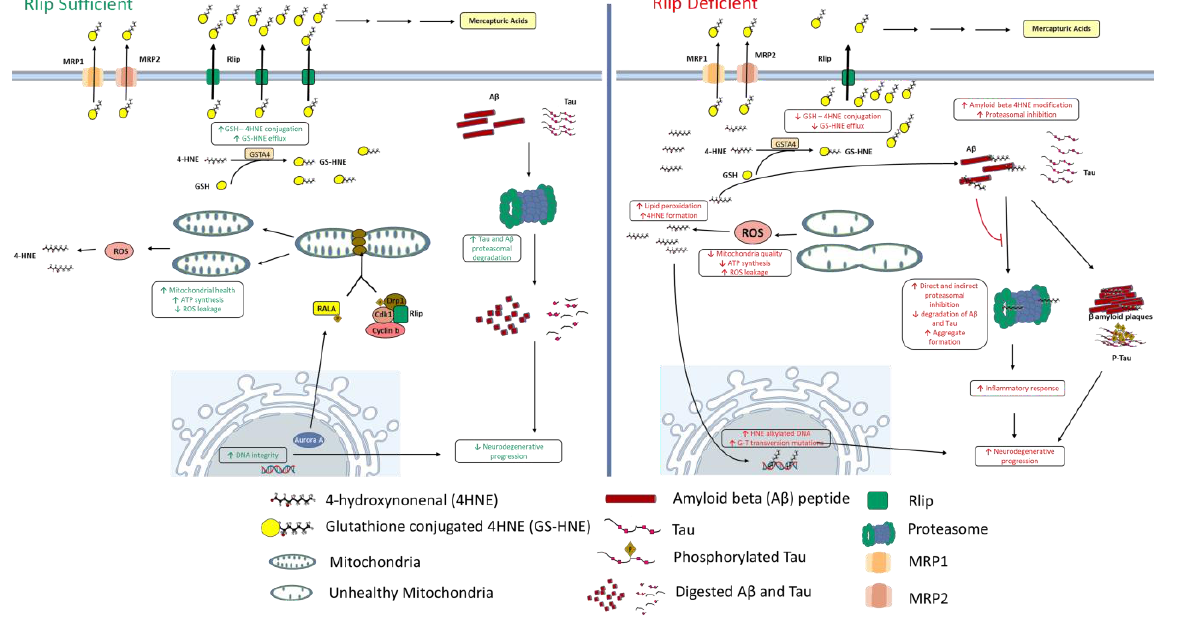
Figure 2. Model of Rlip in mitochondrial health, oxidative stress and DNA damage. The left panel depicts cellular conditions when Rlip is abundant. Under this scenario, mitochondria are healthy and producing minimal ROS, 4- HNE is cleared from the cell, Aβ and Tau are degraded, and the DNA is not subjected to insult. The right panel depicts cellular conditions of Rlip deficiency. Un- healthy mitochondria emit greater ROS, leading to increased 4-HNE production. This 4-HNE is in- efficiently cleared from the cell, causing accumulation. Accumulated 4-HNE can cause adducts on DNA, proteasomes, and Aβ. 4- HNE adducts on both proteasomes and on Aβ can inhibit pro- teasomal function, inhibiting Aβ and Tau degradation and causing inflammation [50 – 54]. Aβ and p-Tau aggregation, along with neuroinflammation, can exacerbate neurodegeneration and progres- sion to AD. Our recent findings show that heterozygous Rlip KO (Rlip +/− ) mice have significant increases in the dentate gyrus and hippocampus expression of Drp1 and Fis1, genes in- volved with mitochondrial fission, and decreased expression of the mitofusin MFN1 [14]. Electron microscopy images of hippocampal and cortical cells in Rlip +/− mice showed a larger number of smaller mitochondrial relative to controls with wild-type Rlip, indicat- ing mitochondrial fragmentation [14]. Consistently, the activity of glutathione peroxidase, a mitochondrial antioxidant enzyme, decreased in the Rlip +/− mice, which also indicates a loss of mitochondrial function [14]. Together, these results suggest that the mitochondria of Rlip +/− mice may be dysfunctional, with impaired energy production and elevated leak- age of ROS into the surrounding cytosol. Supporting a possible energy deficiency, homo- zygous Rlip knockout mice, while viable, tend to remain small and thin. Sperm motility is also highly dependent on mitochondrial ATP production [55], and although we have not formally quantified it, we have clearly observed that homozygous Rlip knockout mice have reduced fertility relative to wild-type littermates. In summary, evidence from the literature suggests that Rlip plays a role in the maintenance of healthy mitochondria, which are key to producing the energy which is critically needed by neurons. We posit that Rlip deficiency may therefore contribute to reduced mitochondrial ATP production, perhaps affecting neuronal vitality and contributing to neurodegenerative diseases. 5. 4-HNE, Oxidative Stress, and Neurodegeneration